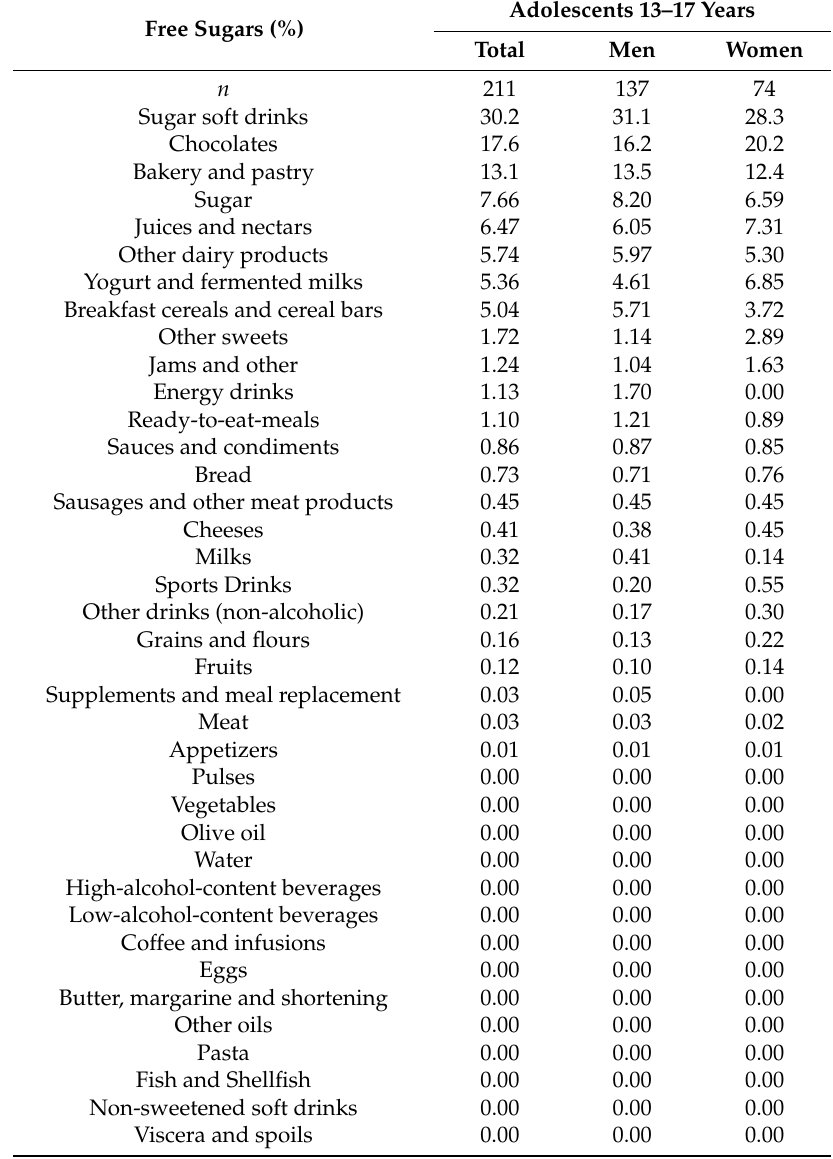
Table 12. Dietary sources of free sugars (%) from food and beverage subgroups in the ANIBES Study Spanish population aged 13–17 years: